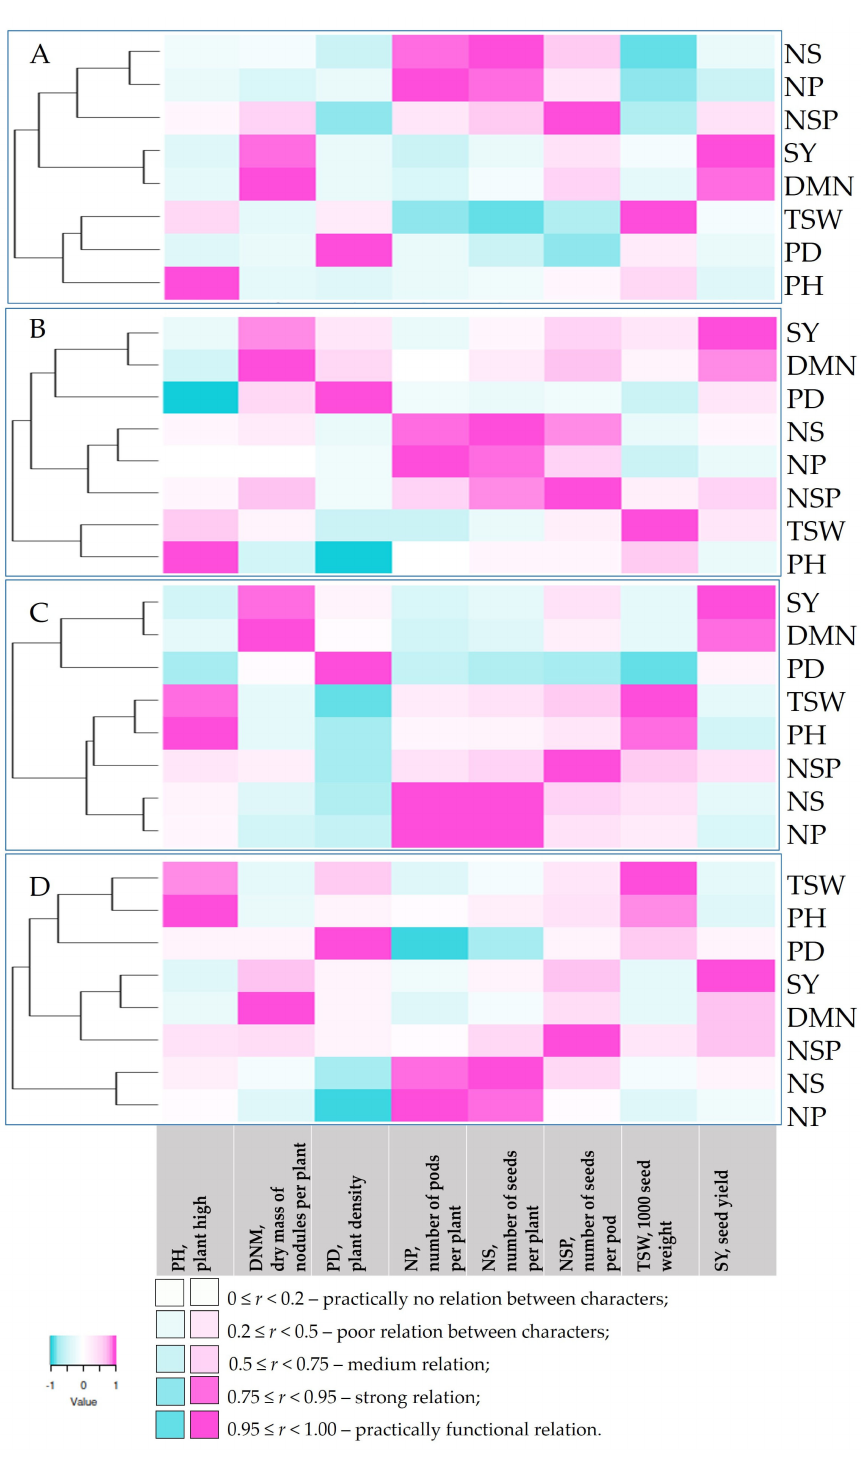
Figure 1. Correlation coefficients between features analyzed for ( A ) Control, ( B ) 30 kg N ha − 1 , ( C ) HiStick ® Soy + 30 kg N ha − 1 , and ( D ) Nitroflora + 30 kg N ha − 1 . Features compared: 1. PH, plant height (cm); 2. DMN, dry mass of nodules per plant (g); 3. PD, plant density (no. m 2 ); 4. NP, number of pods per plant; 5. NS, number of seeds per plant; 6. NSP, number of seeds per pod; 7. TSW, 1000 seed weight (g); 8. SY, seed yield (t ha − 1 ). Interpretation of